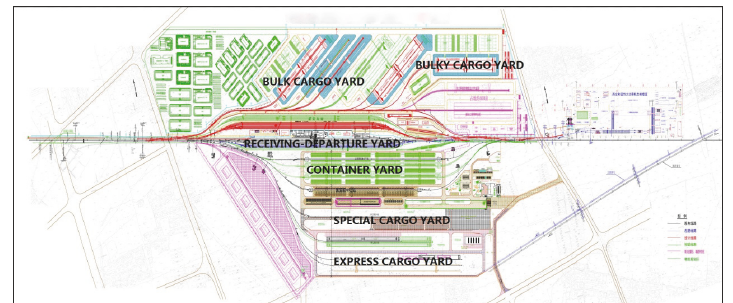
Figure 1: Typical layout of multiyards railway intermodal